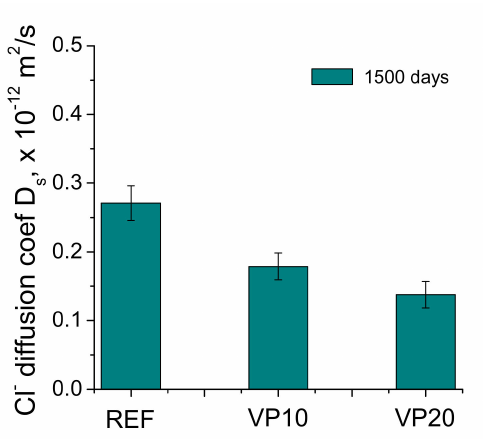
Figure 10. Steady-state chloride diffusion coefficients noted for the binders